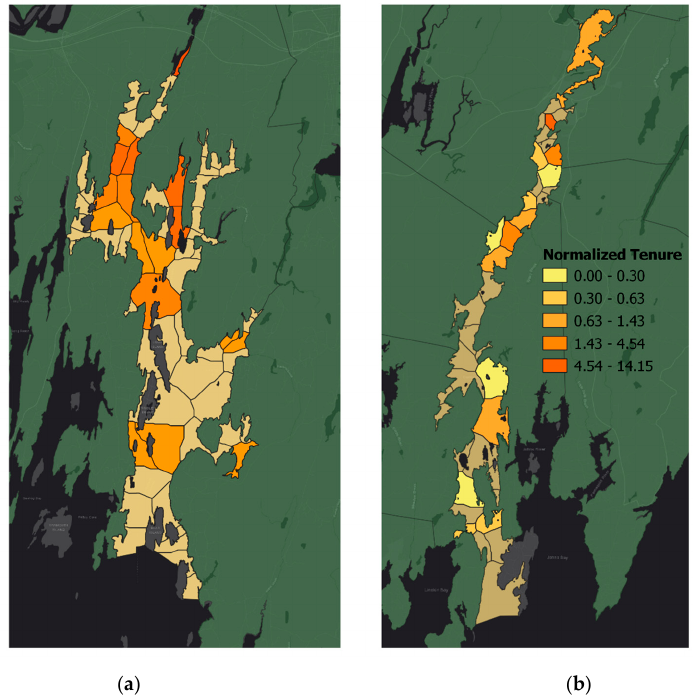
Figure 7. ( a ) Choropleth map of NCT values for New Meadows River estuary and ( b ) Choropleth map of NCT values for Damariscotta River estuary. Basemap © OpenStreetMap contributors, and the GIS user community.